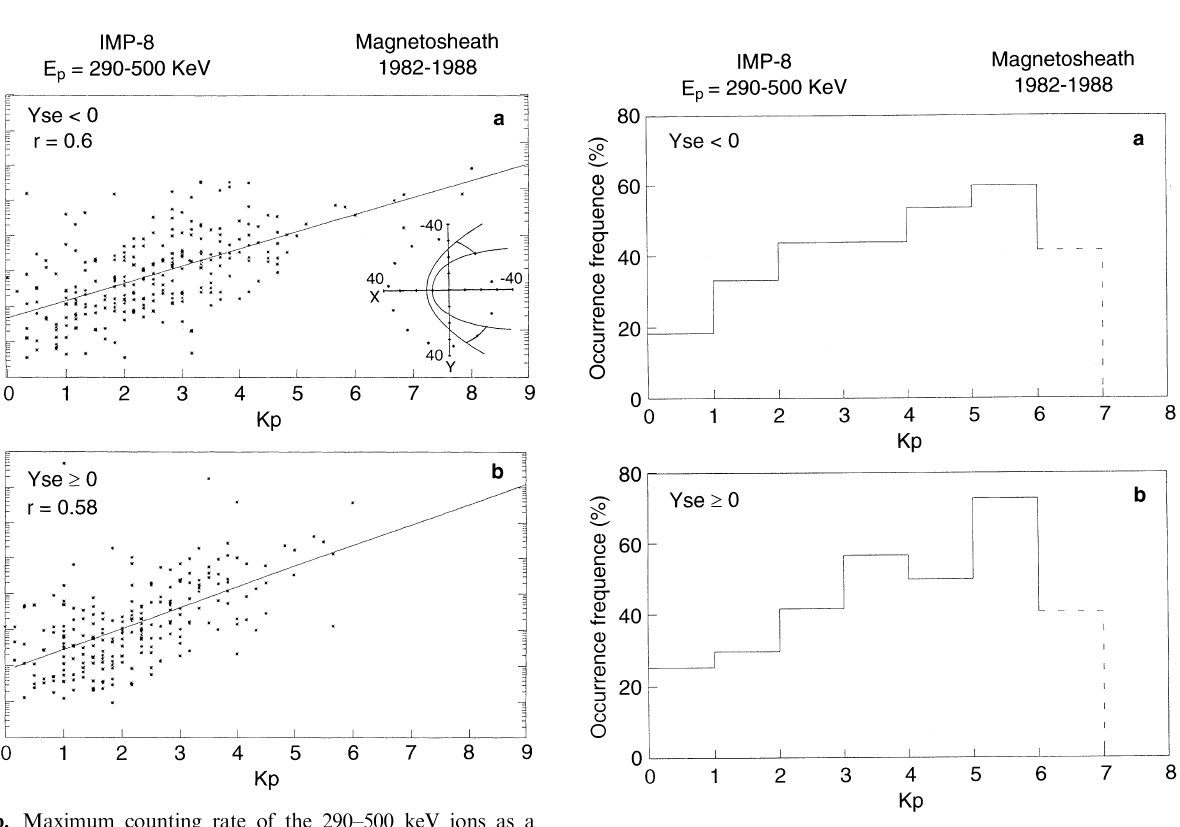
Fig. 2a,b. Occurrence frequency of the 290–500 keV ions as a function of the index Kp in the a dawn and b dusk magnetosheath. The occurrence frequency increases when the index Kp